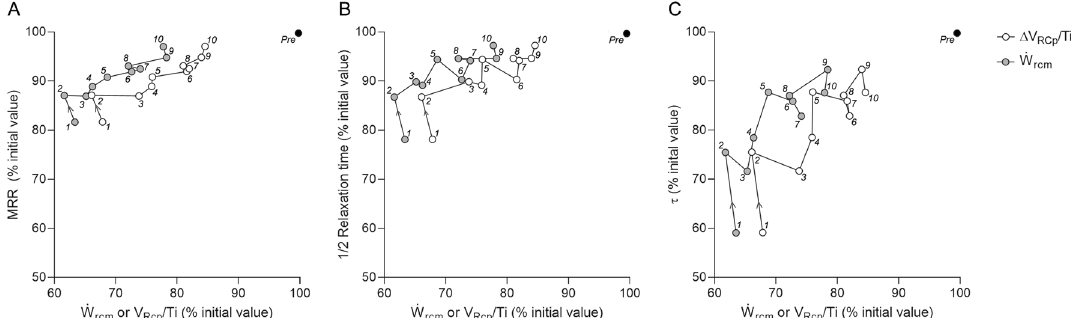
Figure 7. Relative mean changes of maximum relaxation rate (MRR – panel A ), half-relaxation time (½RT – panel B ), and time constant of the relaxation curve (τ – panel C ) in relation to mean changes in shortening velocity index (ΔV RCp /Ti – white dots) and mechanical power ( Ẇ rcm – grey dots) of the inspiratory ribcage muscles during recovery in all 26 subjects included. Numbers near dots represent the order of the SNIP maneuvers during recovery. Note that pre-fatigue values are 100% for y- and x-axis (black dots) and relaxation parameters returned to values above 90% of initial values, while both ΔV RCp /Ti and Ẇ rcm remain below